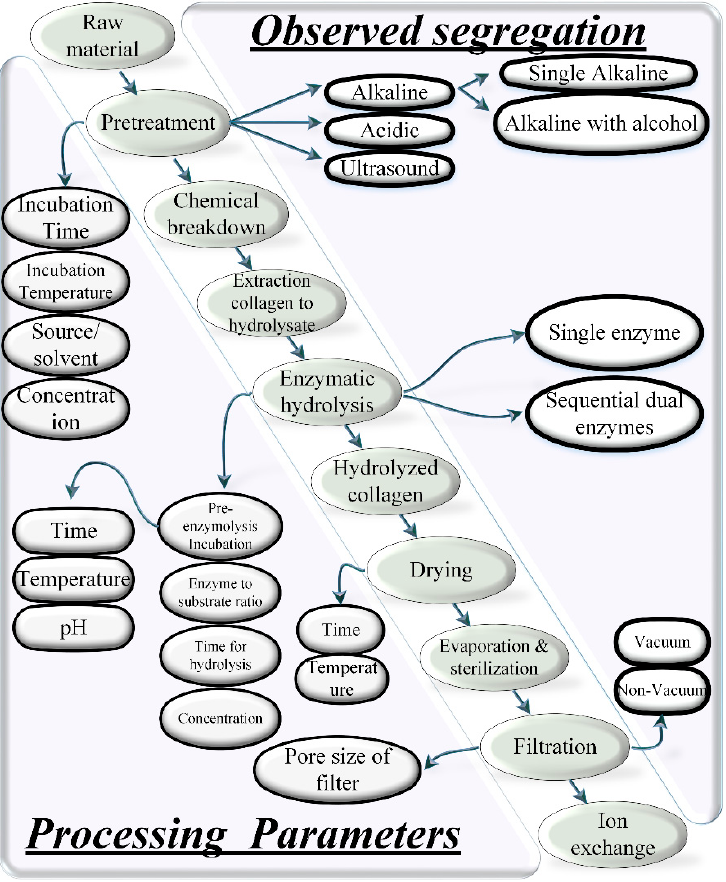
Figure 4. Parameters and categories of the combined chemical and enzymatic hydrolysis.